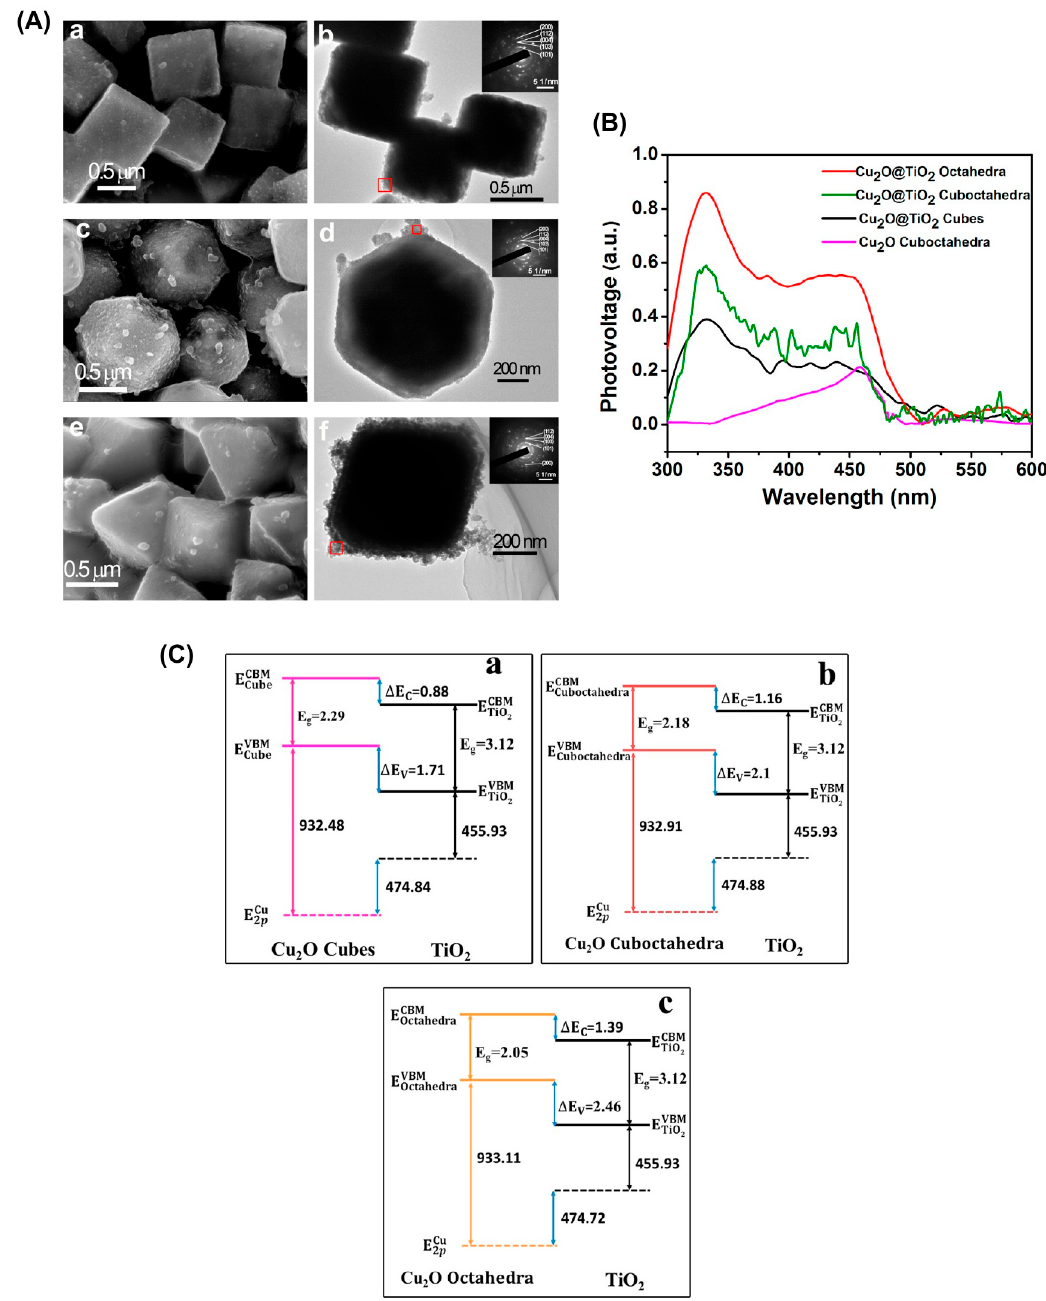
Figure 16. ( A ) SEM and TEM images of Cu 2 O@TiO 2 , Cu 2 O nanocrystals in the shape of cubes—( a , b ) and, cuboctahedra—( c , d ), and octahedra—( e , f ); ( B ) Surface photovoltage spectroscopy (SPS) spectra of Cu 2 O@TiO 2 core-shell polyhedra, compared with that of the as-synthesized Cu 2 O cuboctahedra; ( C ) Energy band diagrams for different types of morphology. Reprinted with permission from [105]. Copyright American Chemical Society, 2015.